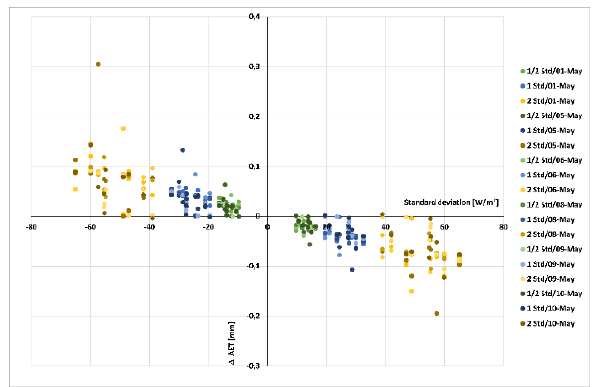
Figure 6. Change of actual evapotranspiration (AET) against the change of DSSF input by one-half standard deviation, 1 standard deviation and 2 standard deviations for several selected days within the first decade of May 2010.